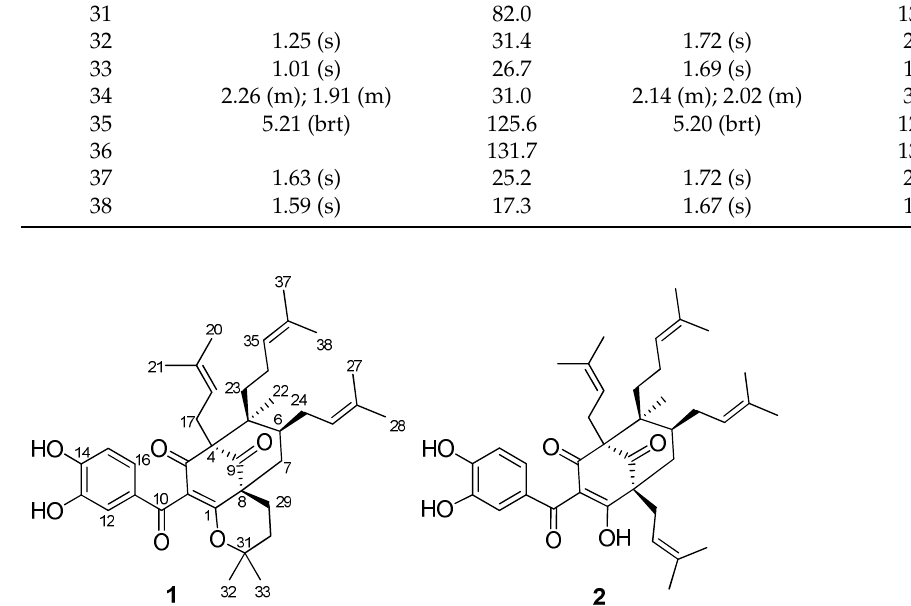
Figure 1. Chemical structures of compounds 1 and 2 .